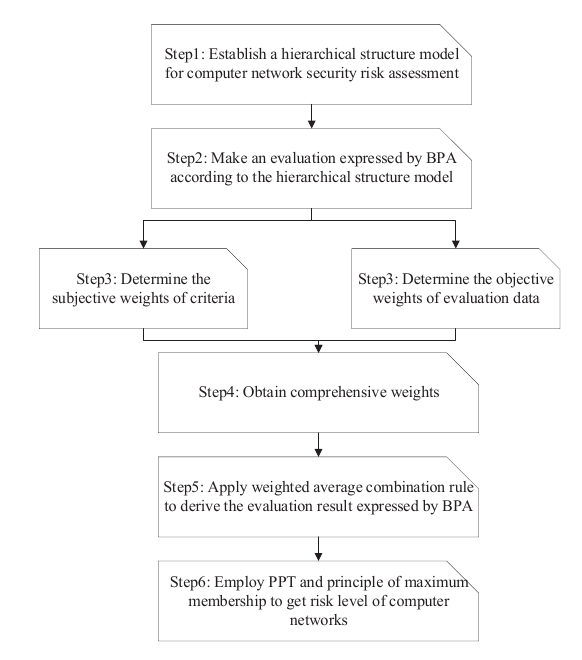
Figure 2. Development of the proposed